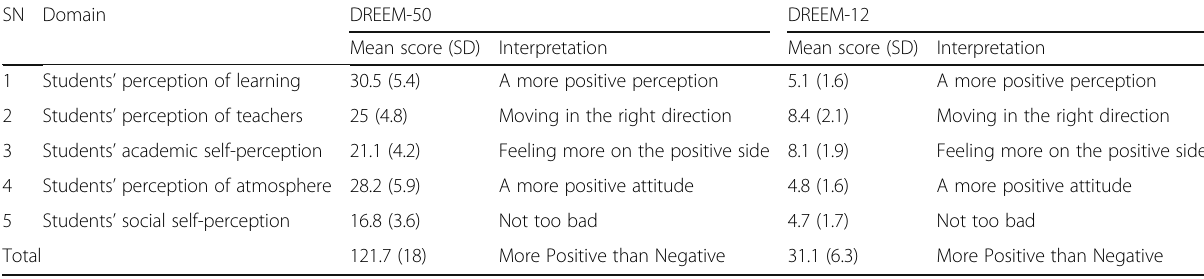
Table 4 Comparison of DREEM-50 and DREEM-12 scores and their interpretation calculated for group II SN